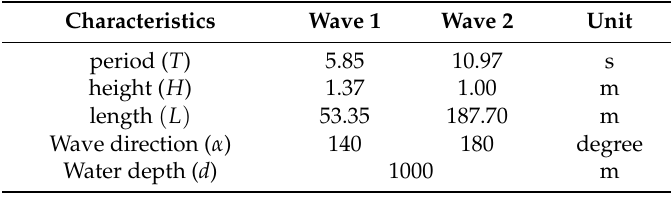
Table 5. Characteristics of two ocean waves.